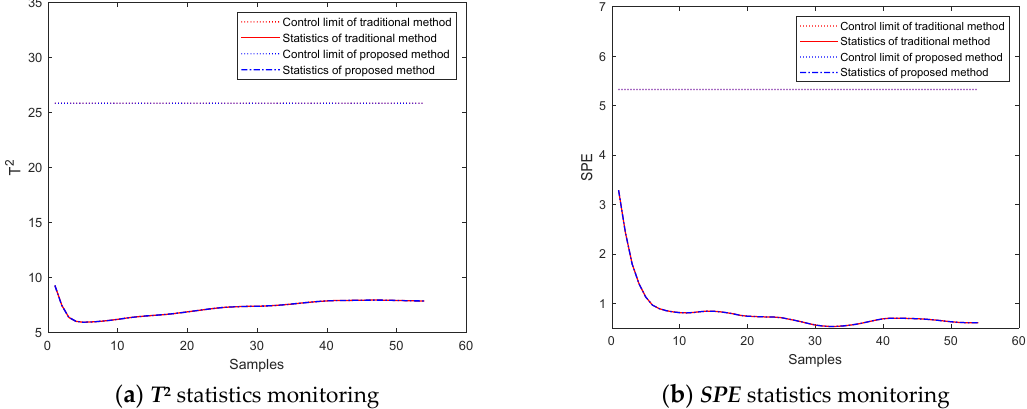
Figure 4. Single-mode online prediction of mode 3.